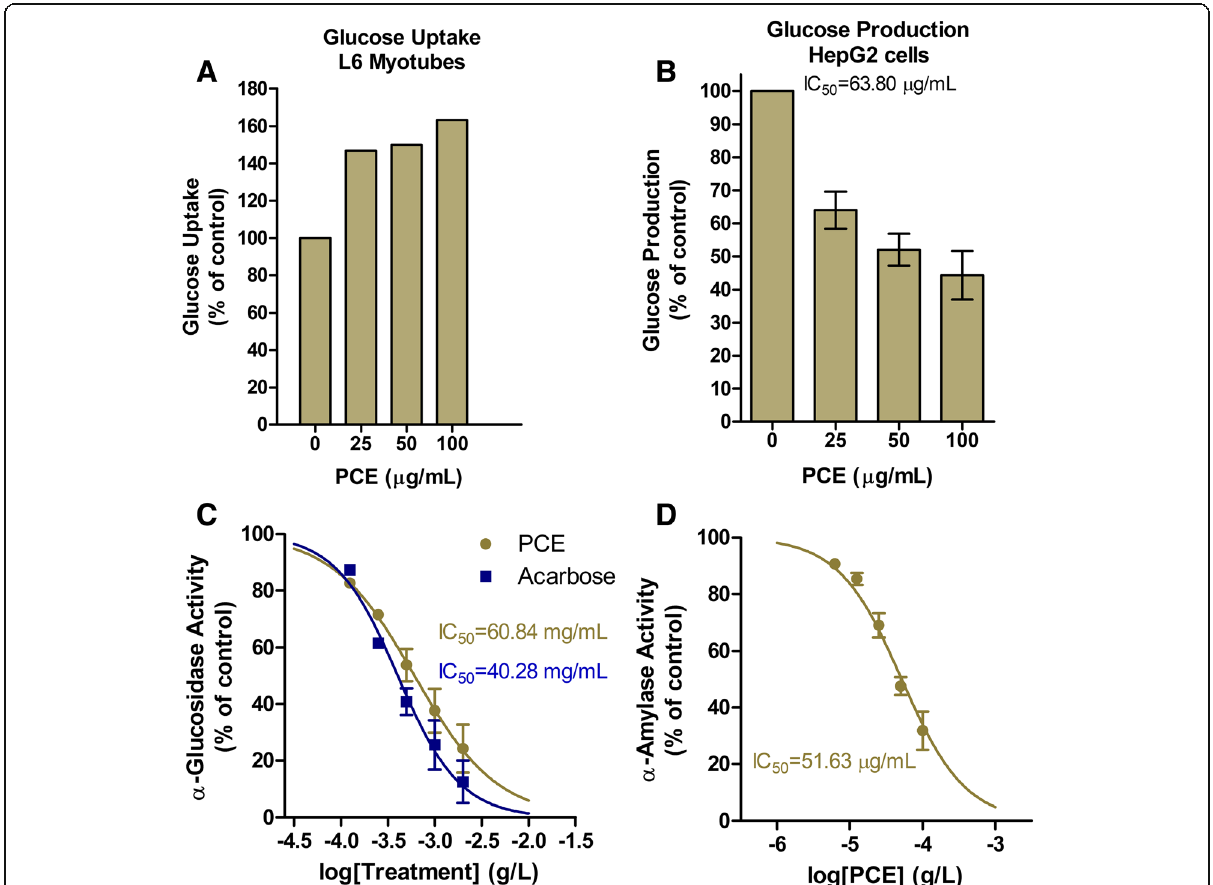
Fig. 4 In vitro effects of PCE on key aspects of glucose homeostasis. ( a ) Glucose uptake in L6 myotubes in the absence or presence of increasing concentrations of PCE. ( b ) Hep2G cell endogenous glucose production in the absence or presence of increasing concentrations of PCE. ( c - d ) Concentration-response curve for PCE ( ) and Acarbose ( ) mediated inhibition of α -glucosidase ( c ) and α -amalyase enzyme activity ( d ) in cell-free systems. All data are represented as mean ± SD percent activity relative to untreated controls. We derived IC 50 values and fit curves using a non-liner inhibitory concentration-response equation with variable slope in GraphPad Prism 5.0